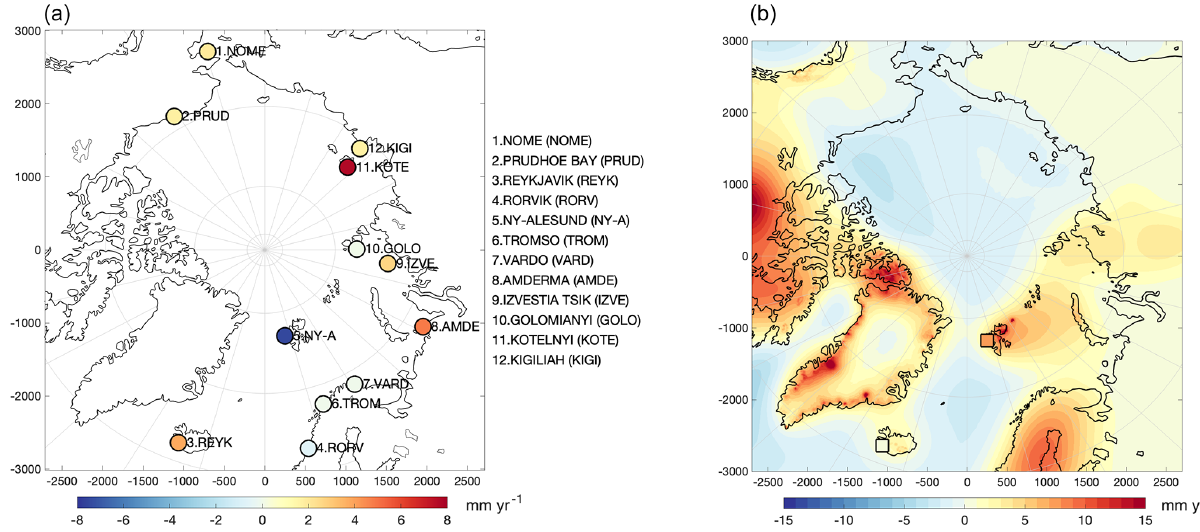
Figure 1. (a) The 1995–2015 RSL trend [mmyr − 1 ] and location of the selected tide gauges of this study. (b) The 1995–2015 VLM trend [mmyr − 1 ] from the model of Ludwigsen et al. (2020b). The VLM trend from the GNSS sites at Reykjavik and Ny-Ålesund are shown with square color-coded